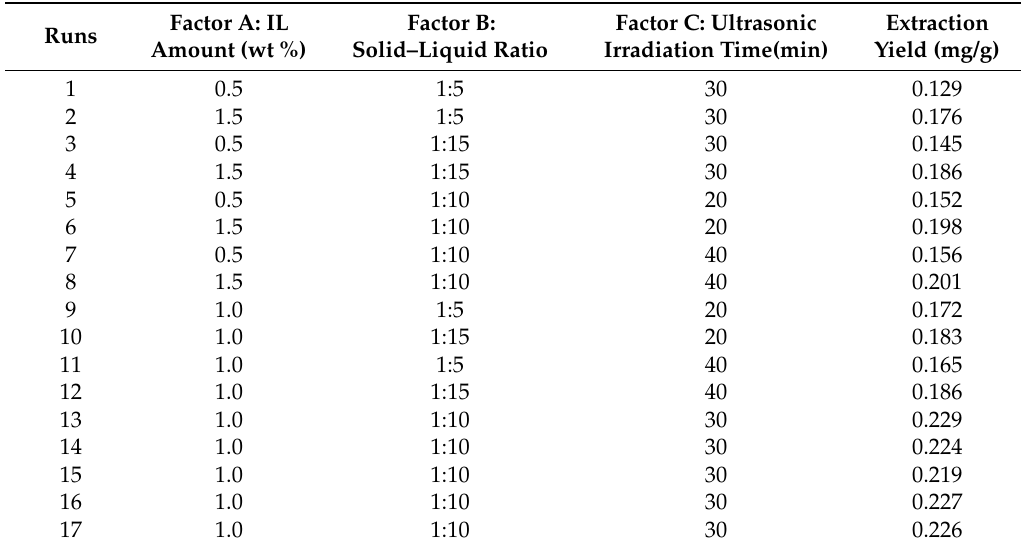
Table 1. Experimental results for the three-factor/three-level Box–Behnken design (BBD).